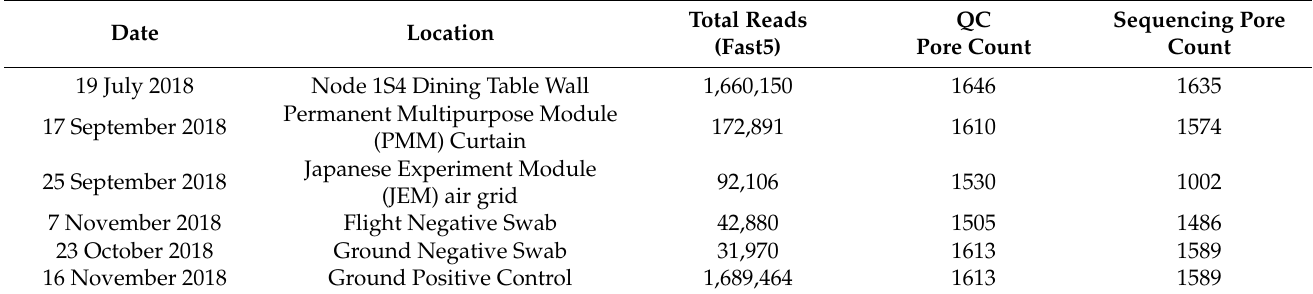
Figure 4. Location of swabbing onboard the International Space Station. ( A ). On July 19, 2018 the Node 1S4 wall adjacent to the crew dining table was swabbed. The area swabbed is directly behind the spoon seen attached to the Node 1S4 interior wall. ( B ). On September 17, 2018 a swab sample was collected from a curtain within the Permanent Multipurpose Module (PMM) that separates the PMM module from the Node 3 module. The area swabbed faces into the PMM. ( C ). On September 24, 2018 a swab sample was collected from an area of the Overhead Aft 7 Air Grid in the Japanese Experiment Module (JEM). Table 1. Nanopore sequencing date, sample location, total FAST5 reads generated and flow cell pore counts onboard the International Space Station and ground